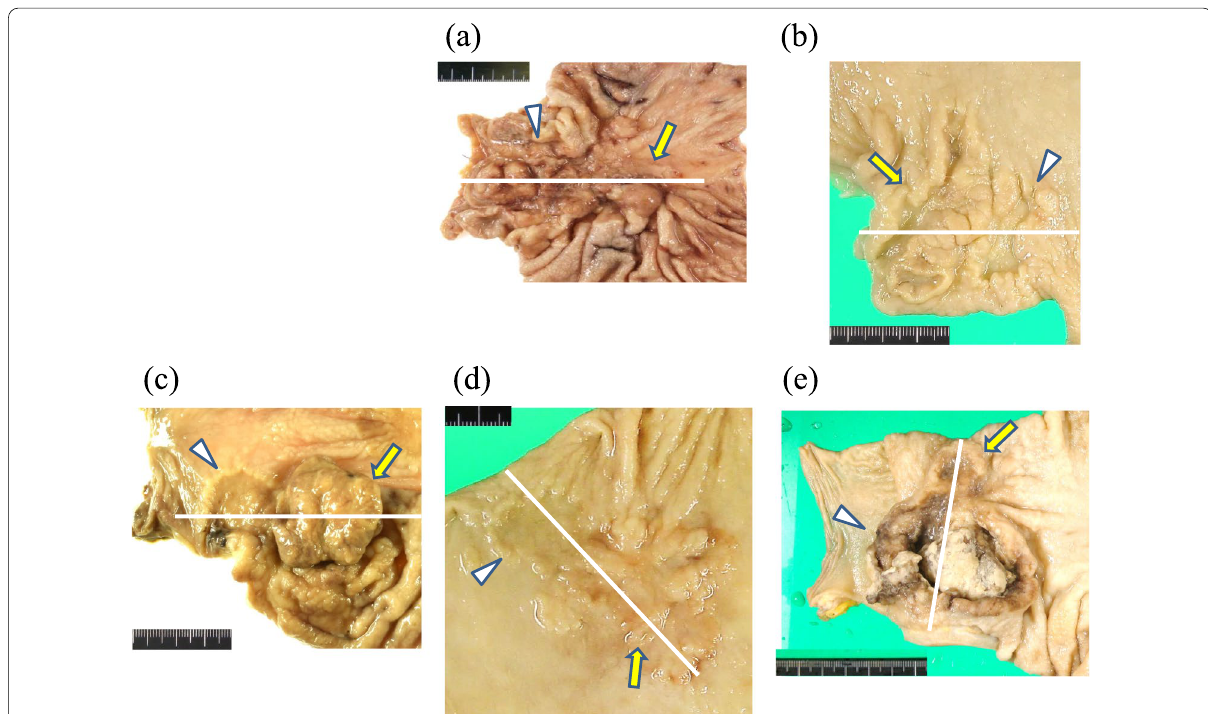
Fig. 2 Images of formalin‑fixed resected specimens divided according to the macroscopic findings of two adjacent lesions. The cutting lines were set perpendicular to the border of two adjacent lesions (arrows and arrowheads). a Case 1: an irregular, depressed lesion in the lesser curvature of the middle and lower stomach (arrow and arrowhead). b Case 2: a large irregular, depressed lesion with marginal protrusion (arrow) and a proximal adjacent depressed lesion (arrowhead) in the posterior wall of the lower stomach. c Case 3: a nodular elevated lesion (arrow) and a distal adjacent depressed lesion (arrowhead) in the posterior wall in the middle stomach. d Case 4: two adjacent irregular, depressed lesions (arrow and arrowhead) in the anterior wall of the middle stomach. e Case 5: a large, well‑demarcated ulcer with marginal protrusion (arrowhead) and an adjacent small depressed lesion (arrow) in the lower